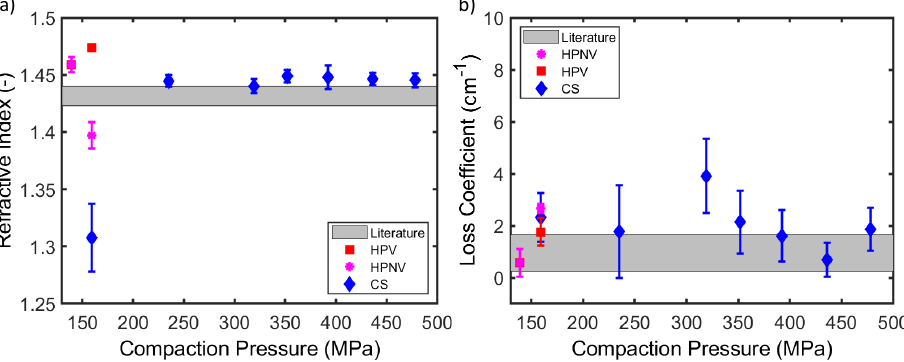
Figure 2. Refractive index ( a ) and loss coefficient ( b ) of PTFE pellets compacted at various pressures. Optical parameters were extracted at 2.45–2.55 THz. Three compaction methods were used: hydraulic press with a vacuum (HPV) and without a vacuum (HPNV) as well as a compaction simulator (CS). Literature values for both RI and loss coefficient are shown as a grey band. The literature is presented as a band reflecting the range of values quoted in the literature [8,28–31]. Values plotted are the mean, with the error bars depicting ± one standard deviation ( n =